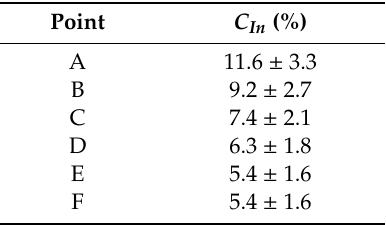
Table 1. Values of the In concentration of the core-shell multiple quantum wells (MQWs) at the di ff erent positions along the axis of the NW indicated in Figure